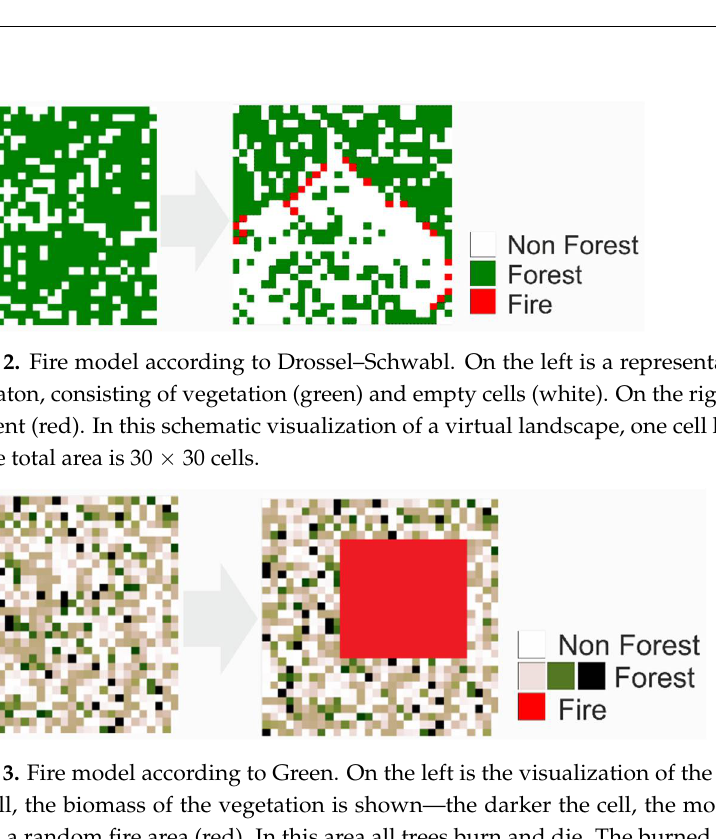
Figure 3. Fire model according to Green. On the left is the visualization of the cellular automaton. In a cell, the biomass of the vegetation is shown—the darker the cell, the more biomass. On the right is a random fire area (red). In this area all trees burn and die. The burned area is immediately repopulated, starting with a low biomass value. In this schematic visualization of a virtual landscape, one cell corresponds to a single plant (e.g., tree), and the total area is 30 × 30 cells.